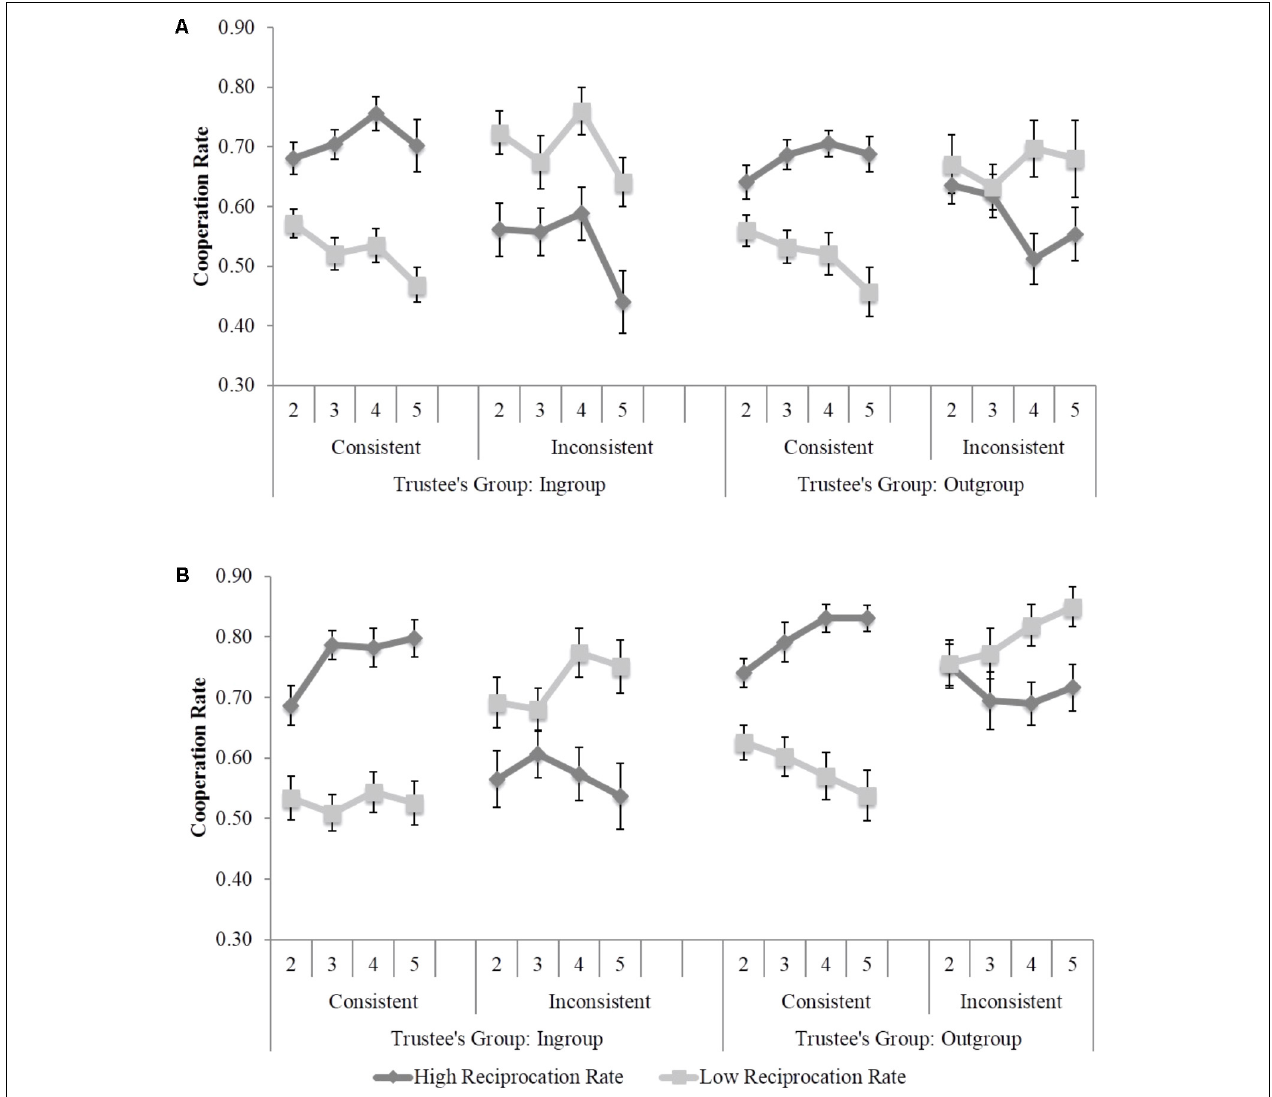
FIGURE 4 | Participants’ cooperation rates in Study 3 as a function of trustees’ group, individual consistency and blocks of trials. (A) White Experimenter Condition. (B) Black Experimenter